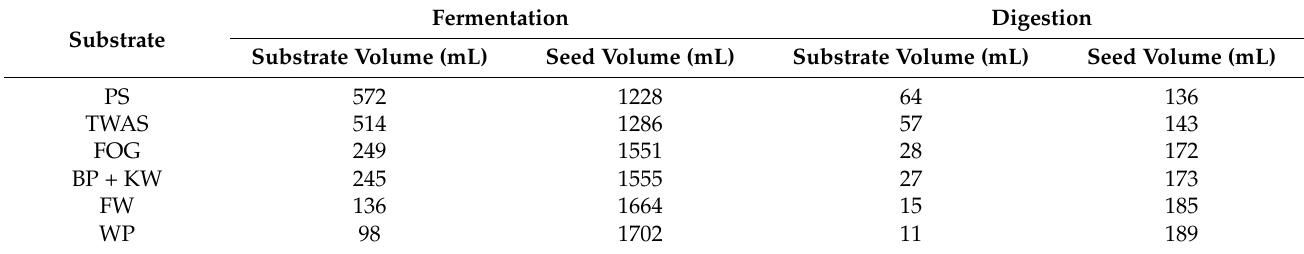
Table 2. Seed and substrate volumes in the fermentation and digestion reactors for each of the tested